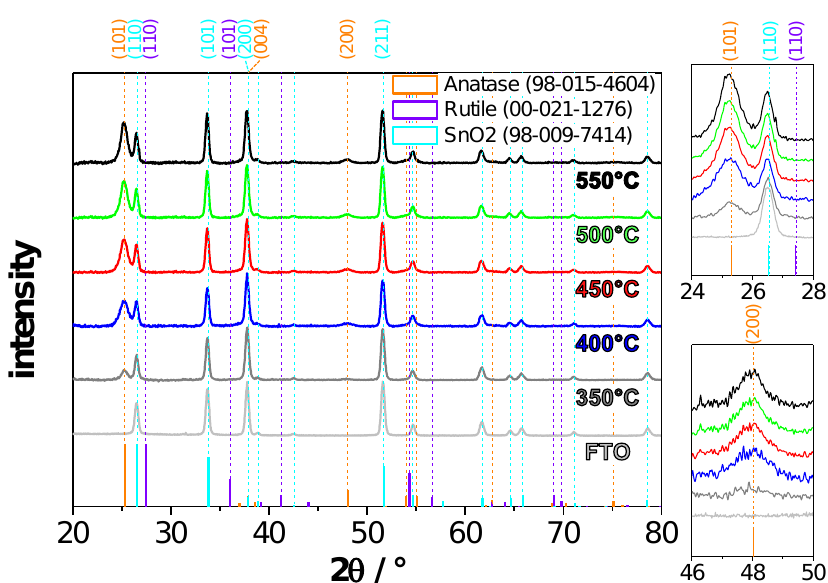
Figure 4. Normalized GI-XRD patterns of single-layered MTTFs calcined at different temperatures. Reference patterns [82–84] and selected hkl values are displayed for better interpretation.